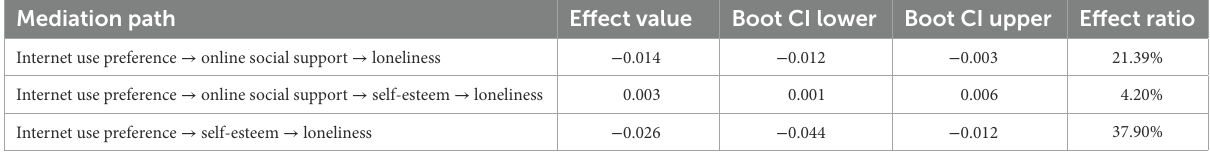
TABLE 3 Analysis of the mediating effects of online social support and self-esteem.